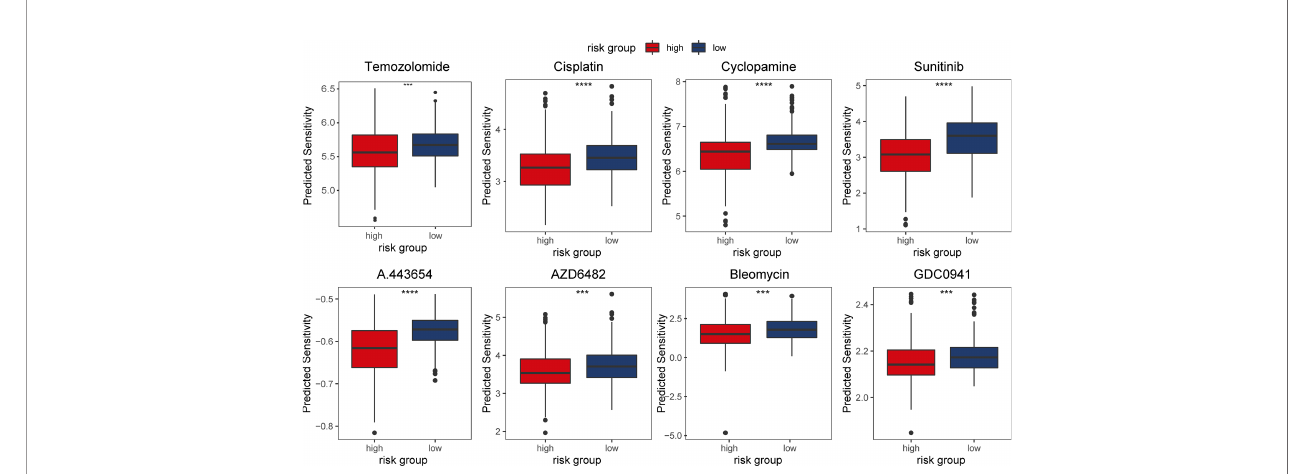
FIGURE 9 | Predicted response of patients in TCGA dataset to chemotherapeutic agents in different risk